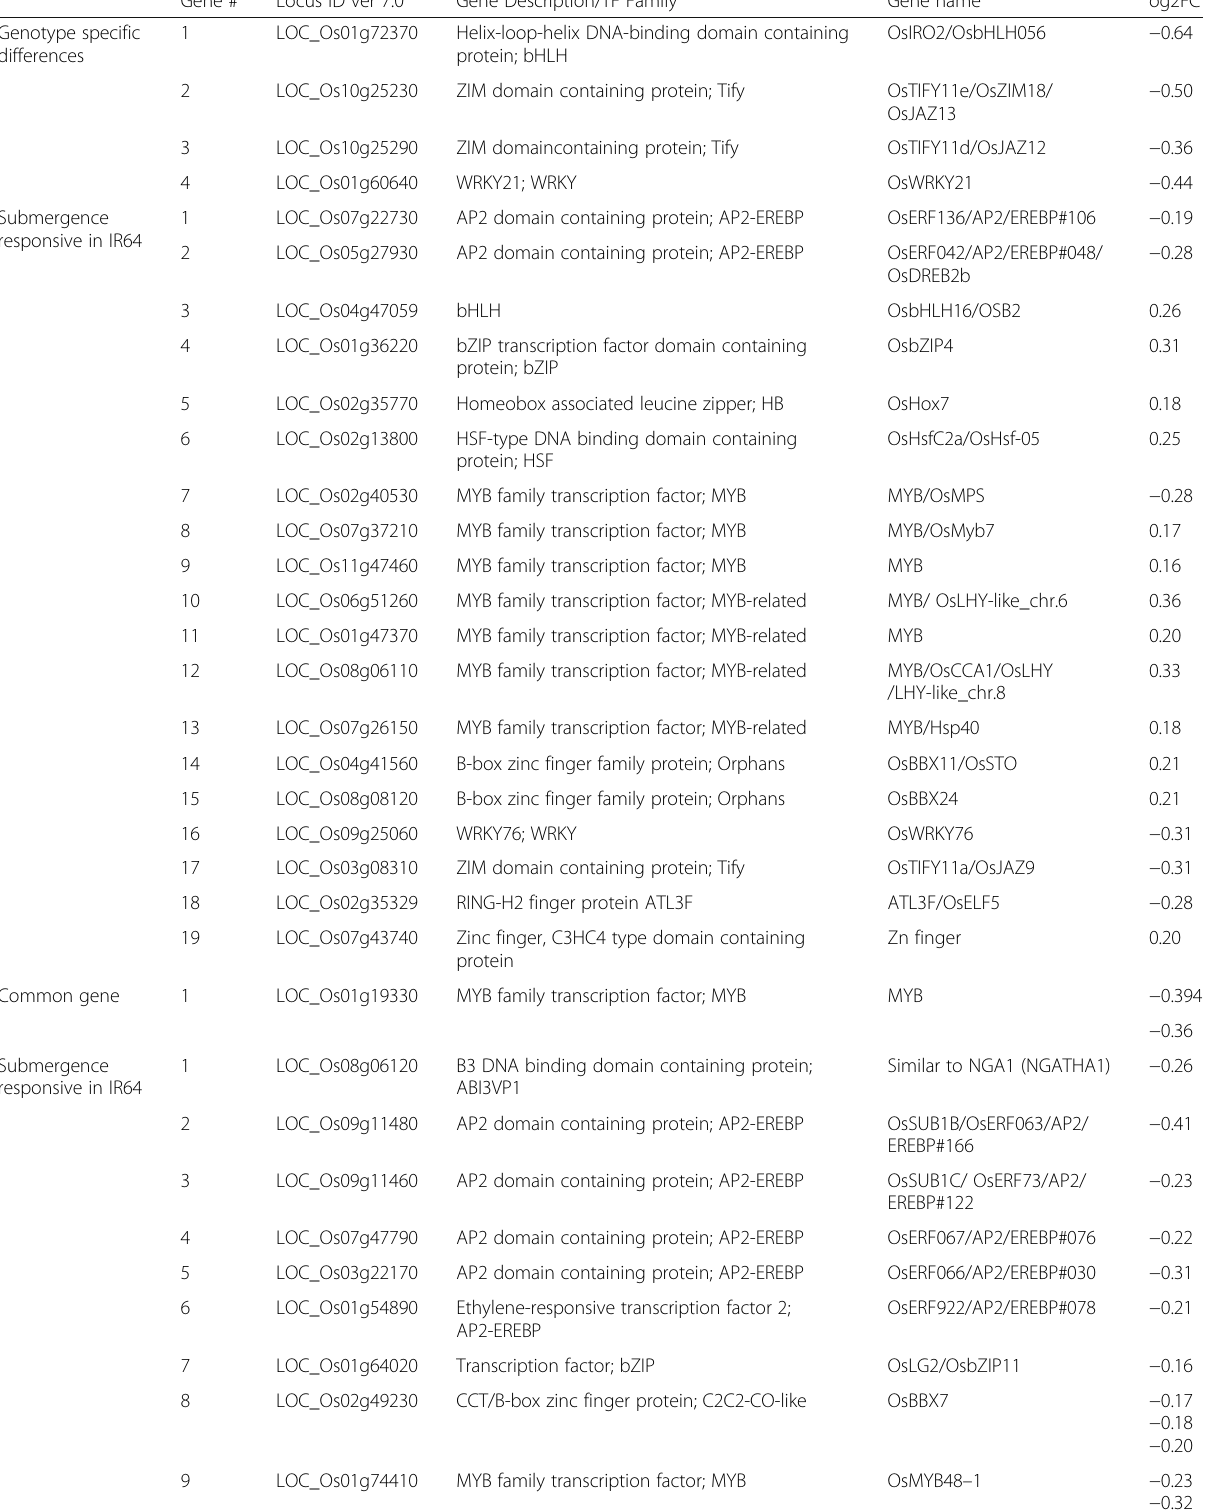
Table 2 Details of the differentially expressed TF genes and their corresponding fold change value (log2FC) under submergence in IR64 and